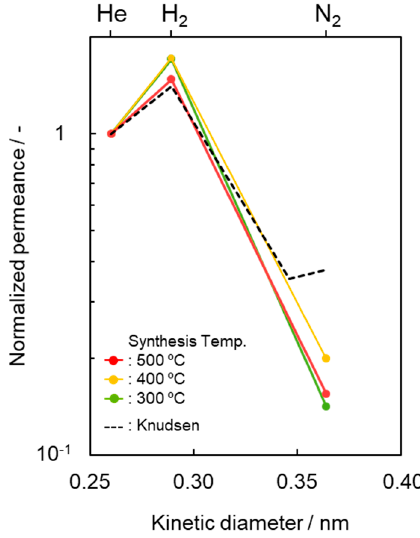
Figure 5. Kinetic diameter dependence of normalized gas permeance based on He permeance ( Q i / Q He ) at 50 °C through the SiCH hybrid/ γ -Al 2 O 3 composite membrane synthesized at different temperatures of 300, 400 and 500 °C. Dotted line indicates predicted values by the Knudsen diffusion model based on He permeance.